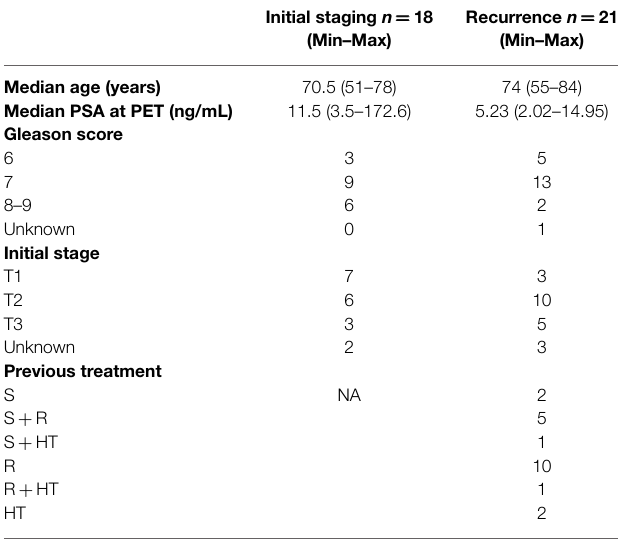
TABLE 1 | Description of patient characteristics ( n === 39) .